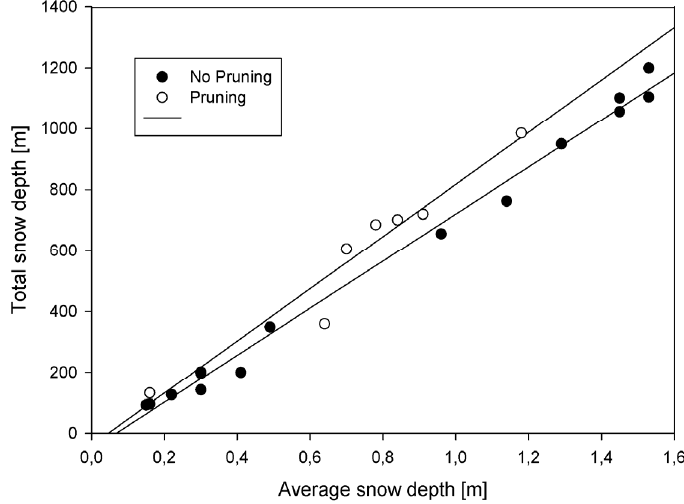
Figure 6. Total snow depth within the study area for the various survey dates, plotted as a function of the average snow depth in Open areas. The data obtained prior to and following canopy pruning are plotted as two data series and two linear adjustments.